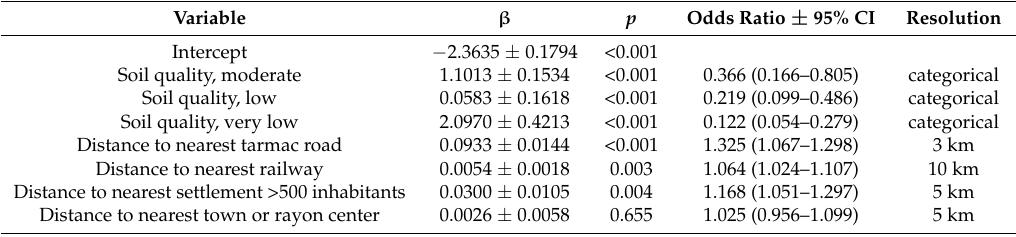
Figure 3. Area of farmed cropland per soil quality category in 1990 and 2015. Table 4. Regression coefficients β ( ± 1 SE), p -values, odds ratios and spatial resolution used for odds ratio calculation for the full model. The full model contained all variables that had a significant relationship with cropland abandonment in univariate regression models. The model fitted the data well (Hosmer–Lemeshow test, χ 2 = 9.212, df = 8, p = 0.325), but there was a lot of unexplained variation (Nagelkerke’s R 2 = 0.15). The discriminative ability of the model was fair (AUC =